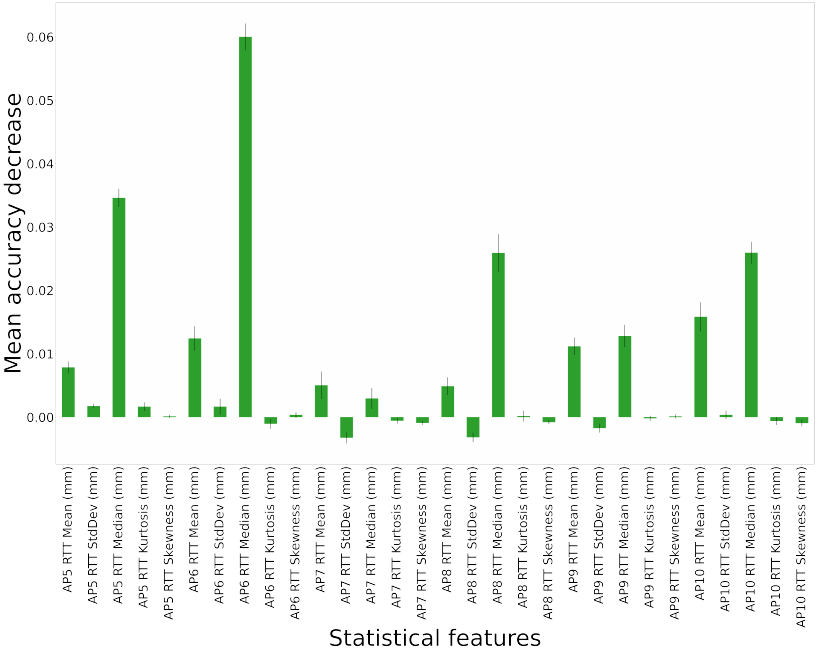
Figure 3. A snapshot of some most important statistical features selected by the Permutation Impor- tance (PI) model. The X-axis indicates different statistical features from the dataset. Negative mean accuracy values indicate that the corresponding features have the least correlation to the ground truth labels. We observe that AP #6 located in the middle of the testbed is the most informative AP for LOS identification.